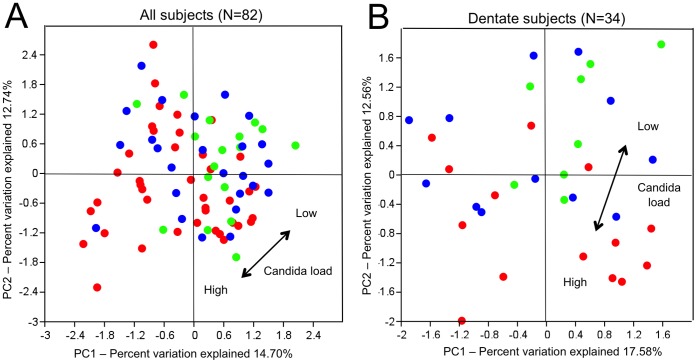
Salivary microbiome data by Candida load.Salivary microbiome data is plotted as OTU-based Principal Component Analysis (PCA) plot by Candida load in A) all subjects (N = 82) and in B) dentate subjects only (N = 34). Samples are colored by Candida load: green - low, blue - medium and red - high Candida load. Arrow indicates the main PC direction between low and high Candida load samples.